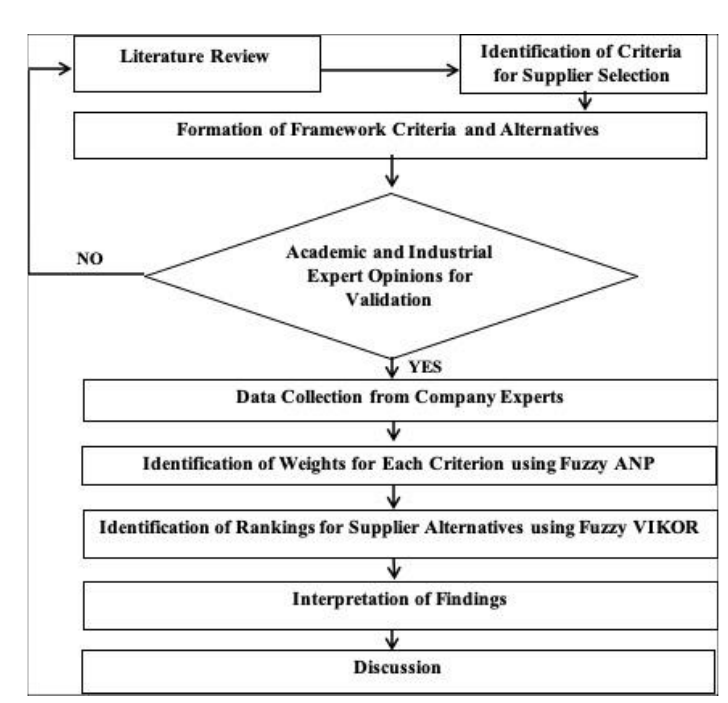
Figure 1. Methodology.